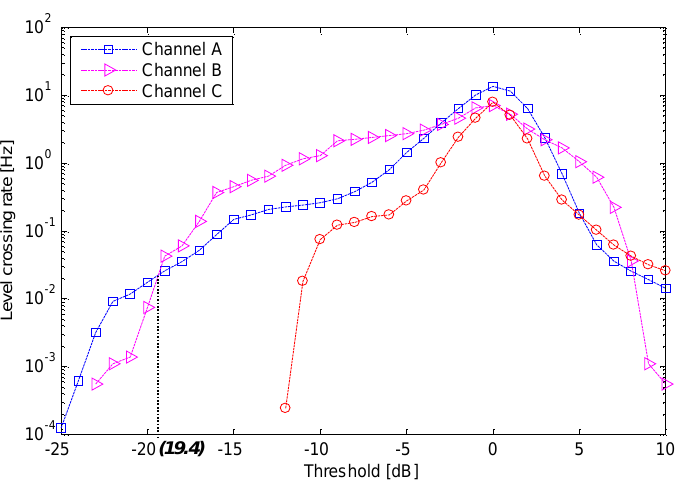
Figure 5. LCRs for the different